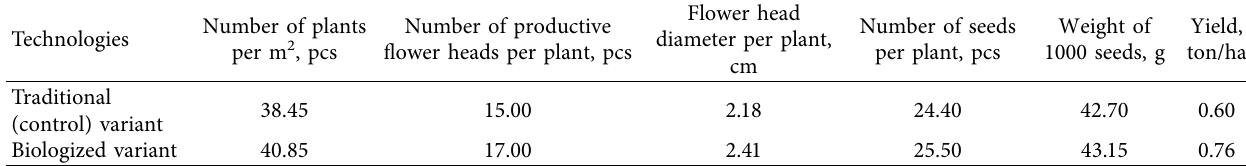
Table 3: Structure of the elements of safflower yield depending on the cultivation technology in zone 1 of West Kazakhstan. Technologies